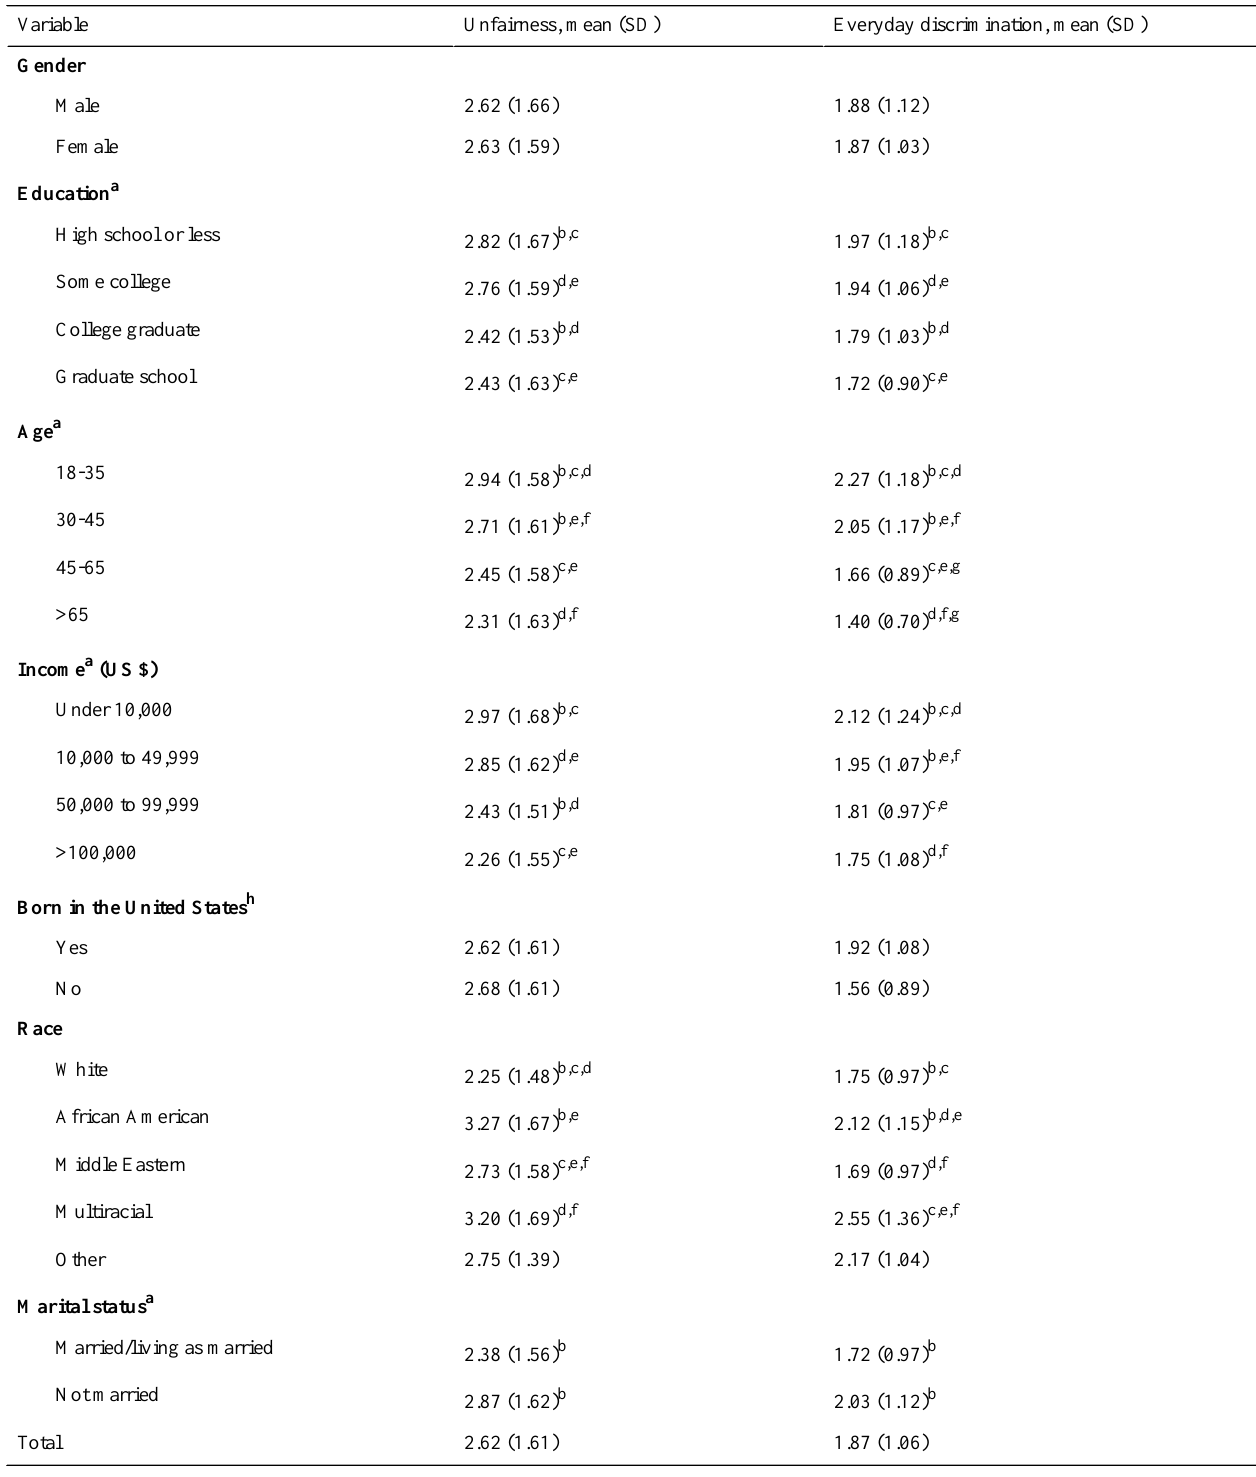
Table 2. Mean scores for unfairness and everyday discrimination by demographic